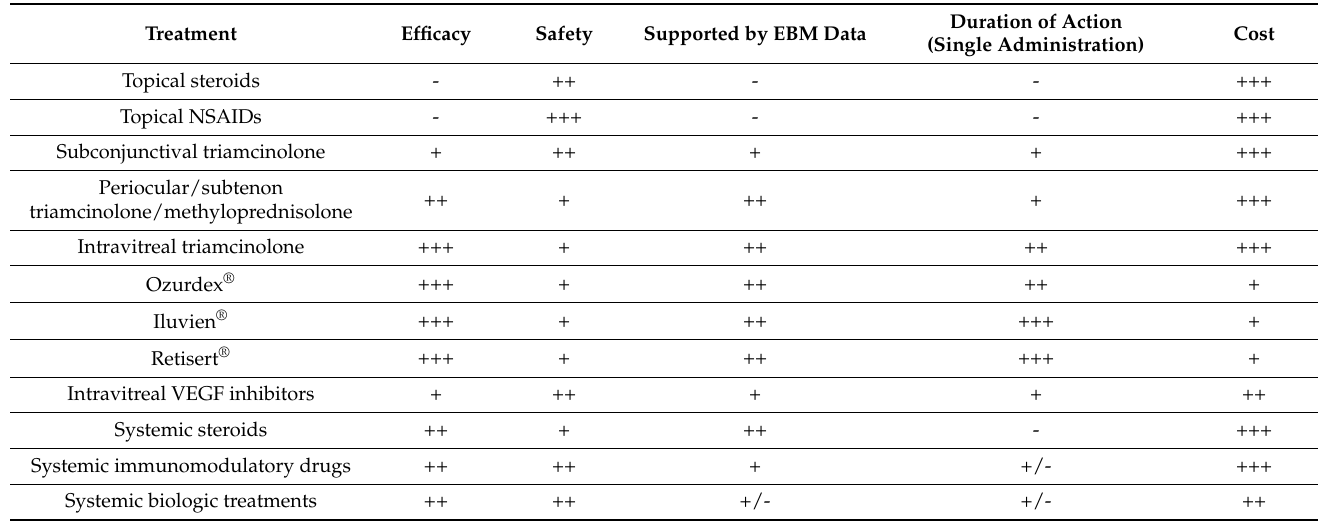
Table 3. Advantages and disadvantages of individual therapeutic options for uveitic ME. Signs in the table: -, +/-, +, ++, +++ are ranked from least to most favorable,